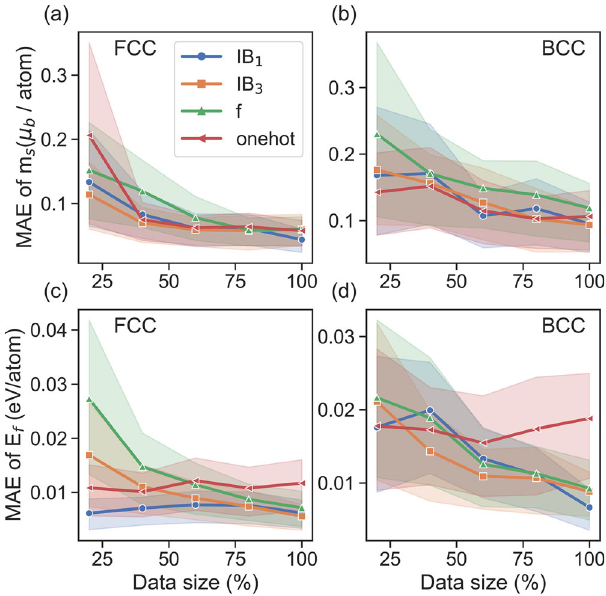
Fig. 5 Model convergence tests for MTL-IB 1 , MTL-IB 3 , MTL-one- hot, and MTL-f. a , b shows the prediction performance of magnetic property for FCC and BCC, respectively. c , d show the performance of formation energy for FCC and BCC, respectively. The shaded areas are the standard deviation across fi ve experiments randomly sampled from the data